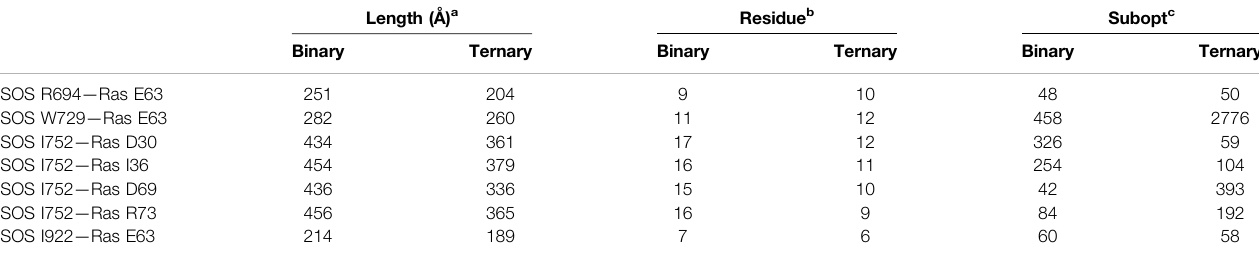
(cid:129) K-Ras4B G13D – GTP interface and the switch I and switch II regions of K-Ras4B G13D